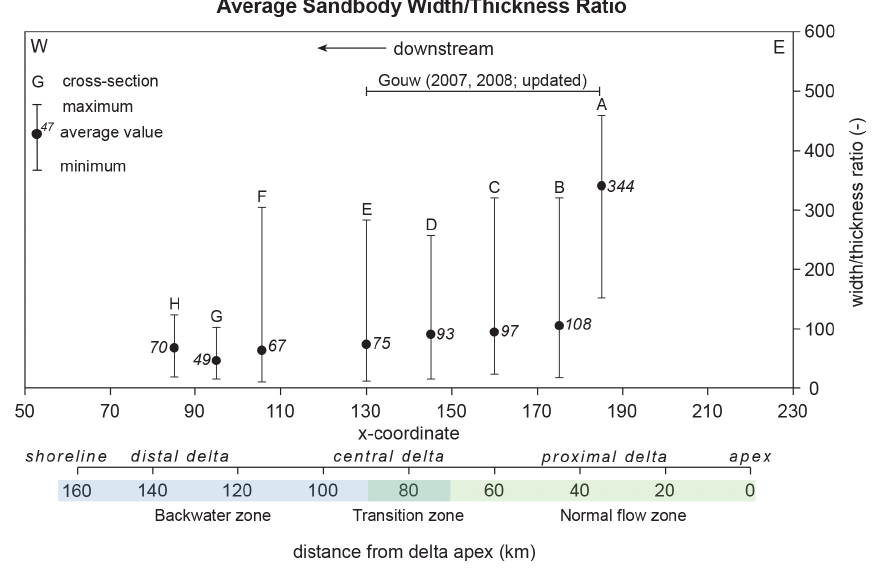
Figure 5. Average width / thickness ratios (SBW / SBT) as calculated for each cross section. The ranges result from applying a thickness of 5.2, 6.7, and 8.2m (average ± 1 σ ) for channel-belt sand bodies with an unknown thickness (Gouw, 2008; cf. Gouw and Berendsen, 2007). The data records in this paper are plotted against the x coordinate because general flow direction is towards the west, which makes the x coordinate a suitable measure for downstream distance. Average SBW / SBT decreases with downstream distance from the delta apex. Data for sections A–E is updated from Gouw (2008, 2007a). Table 3. Data on the total sand proportion (TSP) and its contributors for the Rhine–Meuse fluvio-deltaic wedge. Proportions are relative to the total Holocene fluvio-deltaic succession. Percentages are relative to the total sand proportion. Proportions relative to total Holocene succession (–) Percentage of total sand proportion (%) Cross Relative Total Fluvial Fluvial Estuarine Intertidal Fluvial Fluvial Estuarine Intertidal section distance from sand channel- overbank sands 3 back- channel- overbank sands back- delta apex proportion sands 2 barrier belt sands barrier sands sands 4 sands sands A